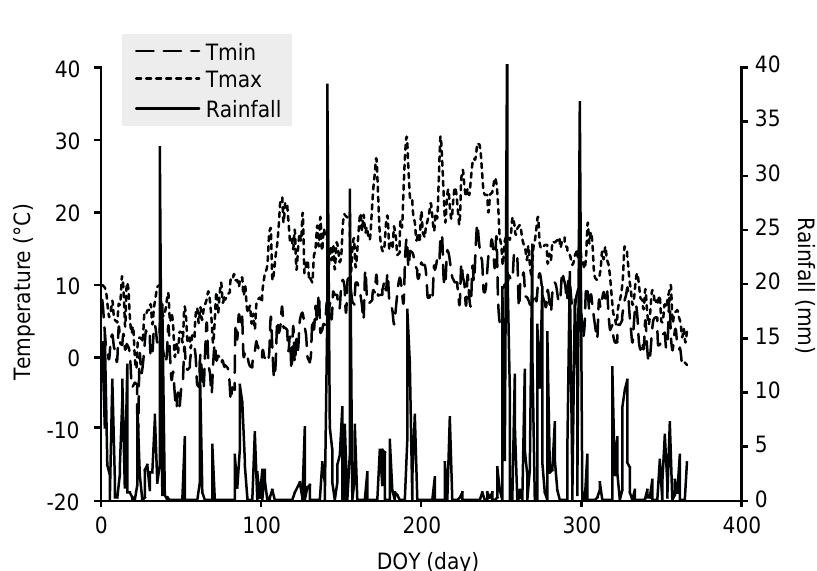
Figure 1. Atmospheric data (rainfall, the minimum and maximum temperature) for Bouwing experiment during 1983 to